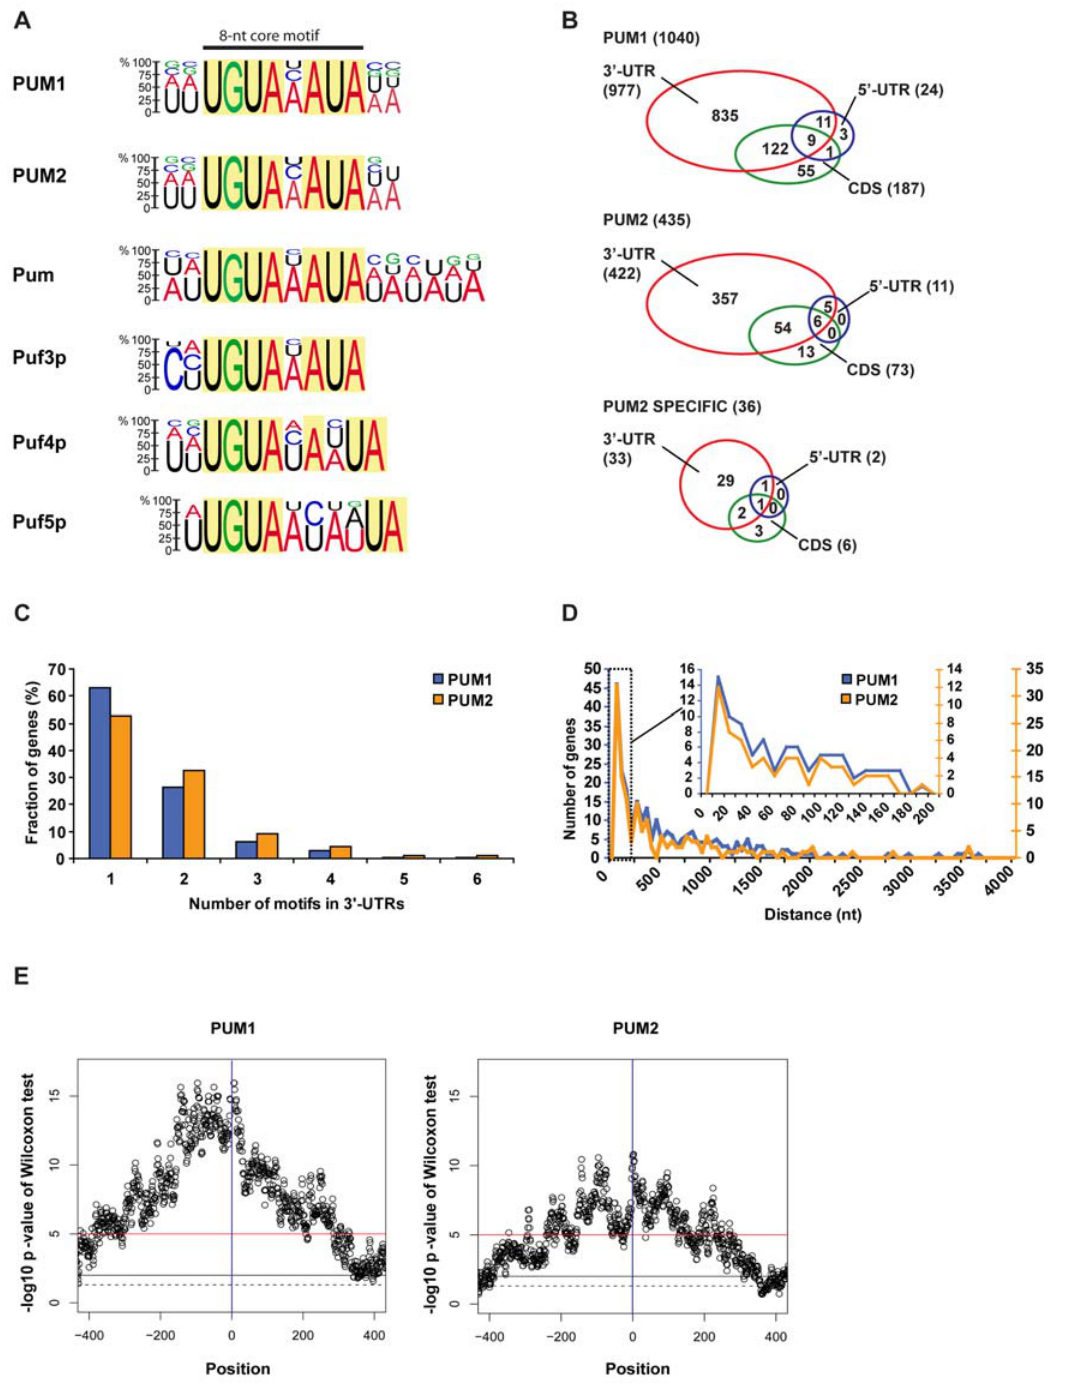
Figure 3. Analysis of an RNA consensus sequence associated with human PUM proteins. (A) PUF consensus motif in 3 9 -UTR sequences associated with PUM1, PUM2, Drosophila Pum and yeast Puf3, Puf4 and Puf5 proteins [35,36]. Height of the letters indicates the probability of appearing at the position in the motif. Nucleotides with less than 10% appearance were omitted. (B) Distribution of PUF consensus motifs. (C) Number of PUF motifs in the 3 9 -UTRs of PUM bound messages. (D) Distances between double PUF motifs present in 3 9 -UTR. Represented bins are 50 nts (0–4000 nts distance) and 10 nts (0–200 nts distance). (E) Analysis of PUF motif conservation among PUM1 and PUM2 targets. The x-axis shows the position (relative to the middle of the PUF motif), and the y-axis shows the logarithm (base 10) of the p -value from the Wilcoxon test determining whether conservation scores come from the same distribution for PUM targets and non-targets. The vertical blue line is drawn at position 0 corresponding to the PUF motif. The dashed black line is drawn at a p -value of 0.05, the continuous black line at a p -value of 0.01, and the red line at a p -value of 10 2 5 , which is the threshold for significance considering multiple testing.